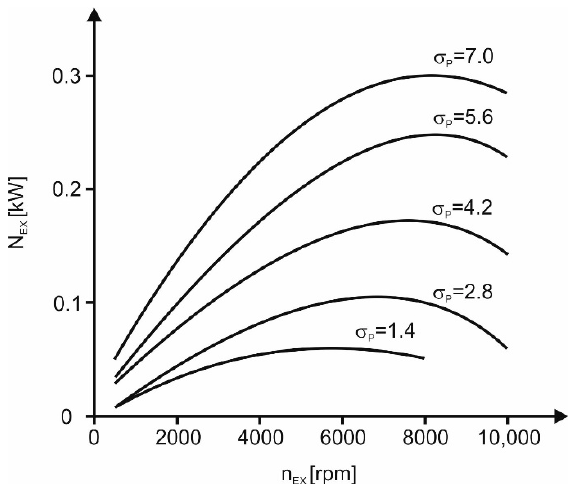
Figure 7. The influence of the expansion ratio and rotational speed of the expander shaft on the expander power output.